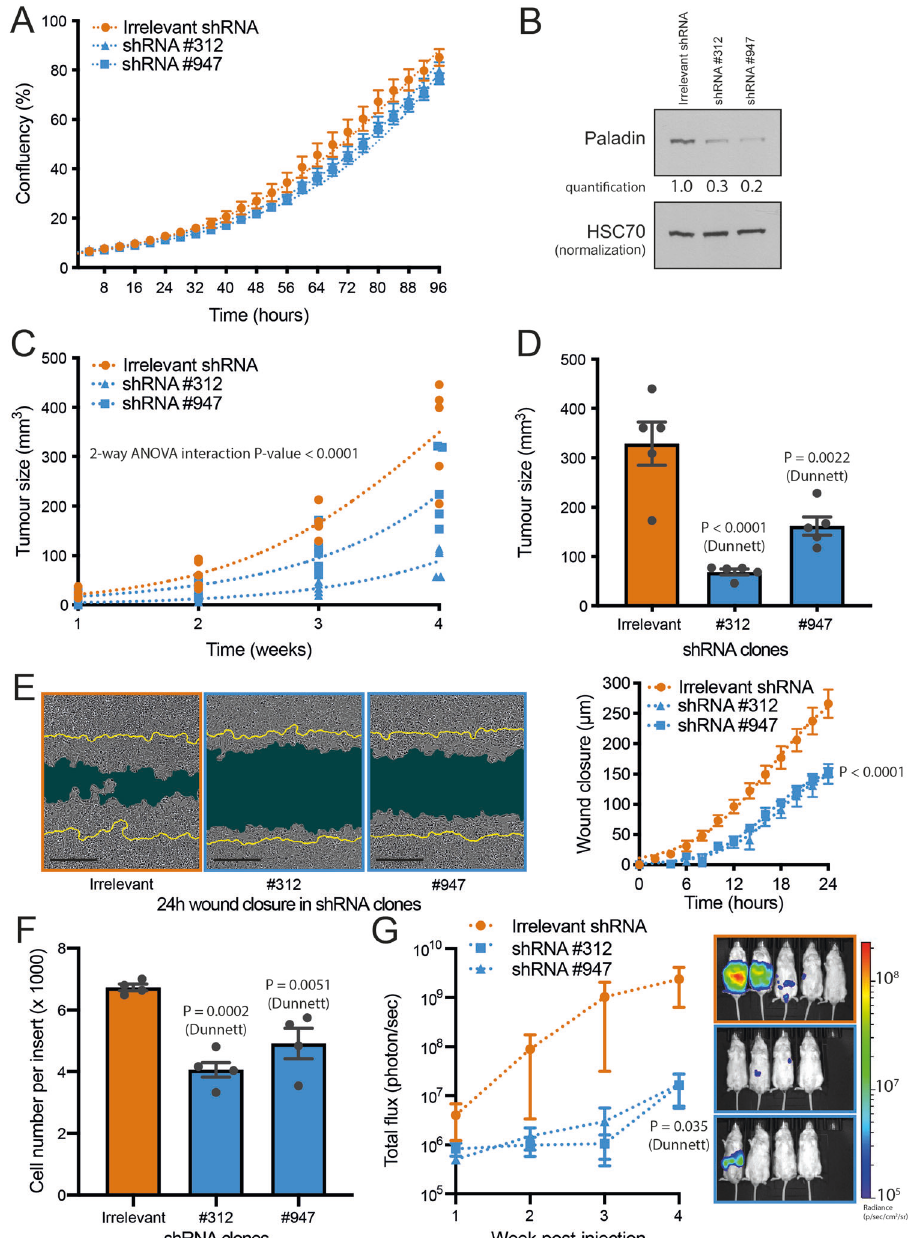
Fig. 3 Paladin is required for tumour growth, cell migration, and metastatic dissemination. A Cell proliferation was analysed in paladin- deleted HCT116 clones using Incucyte for 96 h. Cell growths were fi t by least square regression and compared by the extra sum-of-squares F test ( n = 4). B Paladin western blot in HCT116 paladin shRNA clones. HSC70 was used as a loading control. C Kinetic tumour growth of mice ( n = 5) injected subcutaneously with HCT116 paladin shRNA clones. Individual biological replicates are depicted while curves were fi t according to an exponential growth model by least square regression. Results were compared by 2-way ANOVA. D Endpoint size of tumour resected from mice injected subcutaneously with HCT116 paladin shRNA clones. Bars represent mean ± sem ( n = 5) associated with individual experimental replicates. Groups were compared by 1-way ANOVA followed by Dunnett ’ s pair comparisons. E Representative images (24 h post-scratch) of wound-healing experiments with HCT116 paladin shRNA clones. Scale bars represent 400 µm. Images were individually analysed and quanti fi ed. Dots represent mean ± sem ( n = 6) while curves were fi t according to a logistic model by least square regression and compared by the extra sum-of-squares F test. F Boyden chamber migration of HCT116 paladin shRNA clones was individually analysed and quanti fi ed. Bars represent mean ± sem ( n = 4) associated with individual experimental replicates. Groups were compared by 1-way ANOVA followed by Dunnett ’ s pair comparisons. G In vivo imaging of liver metastatic lesions in mice injected with HCT116 paladin shRNA clones. Results were represented as mean ± sem ( n = 4 – 5). Groups were compared by 2-way ANOVA followed by Dunnett ’ s pair